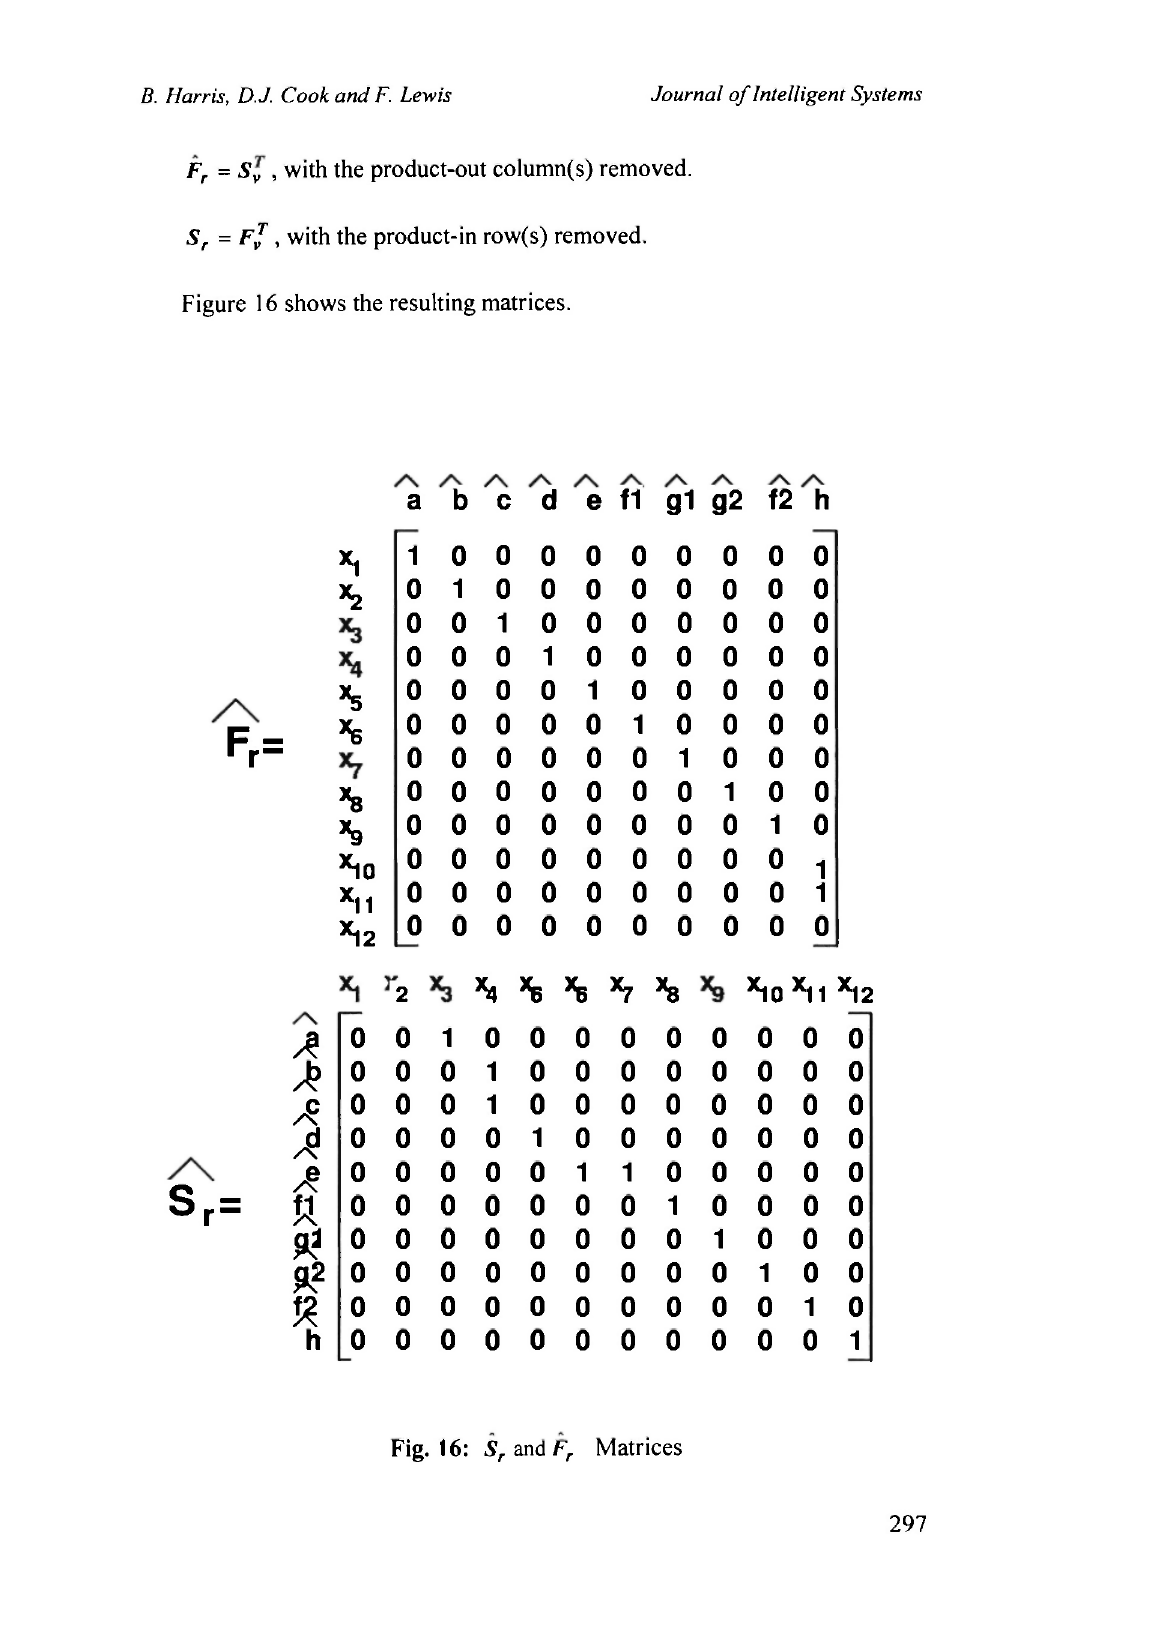
Fig. 16: S r and F r Matrices